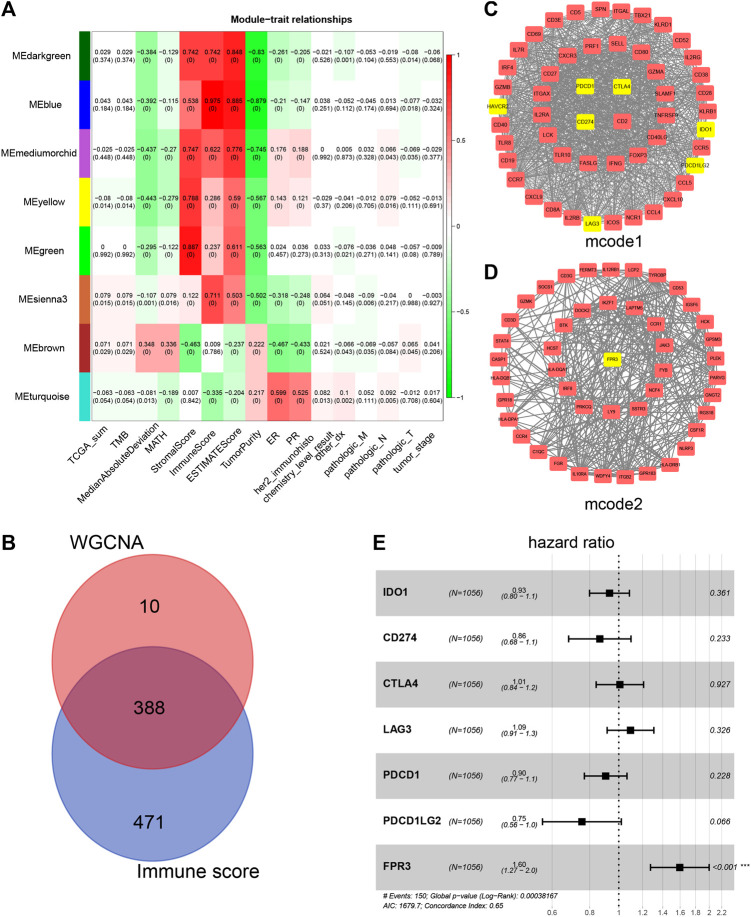
Network visualization plots by WGCNA (A) Module-trait associations. Each row corresponds to a gene module, and each column corresponds to a trait. Each cell was labeled by the corresponding correlation coefficient and p-value (B) Venn diagram shows the genes obtained by the intersection of genes in the WGCNA Meblue module and genes upregulated in high Immune score group (C–D) Cytoscape analysis of 388 intersecting genes yielded two most significantly related MCODE modules. Some known immune checkpoints and FPR3 are marked yellow (E) Multivariate Cox analysis was utilized to analyze the hazard ratio (HR) of FPR3 and some known immune checkpoints.